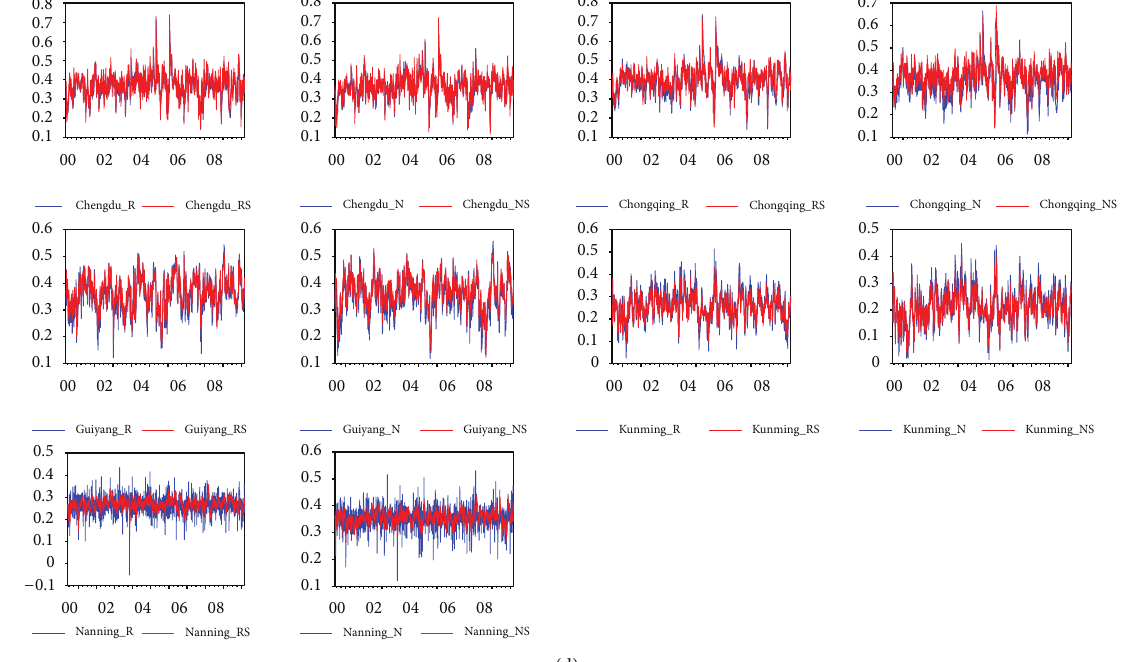
Figure 2: Dynamic correlation